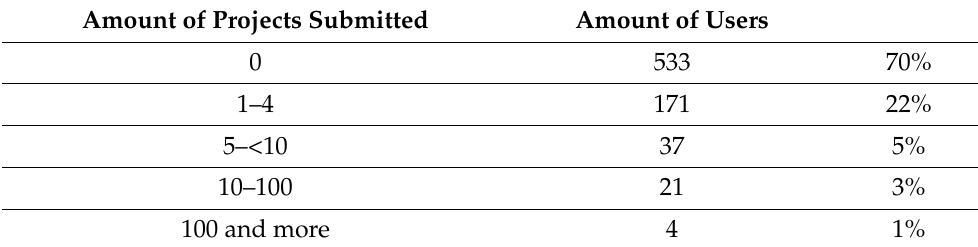
Table 3. Level of involvement of registered users (based on data from ClimateScan database).